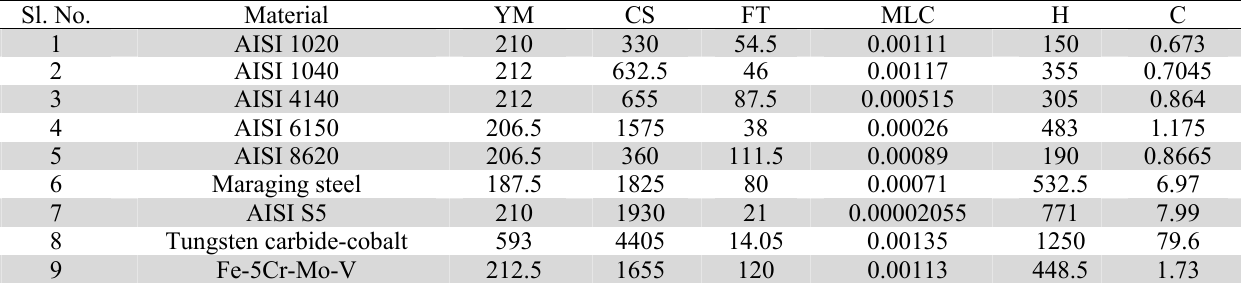
Decision matrix for tool holder material selection problem (Çal ı ş kan et al., 2013) Sl. No.